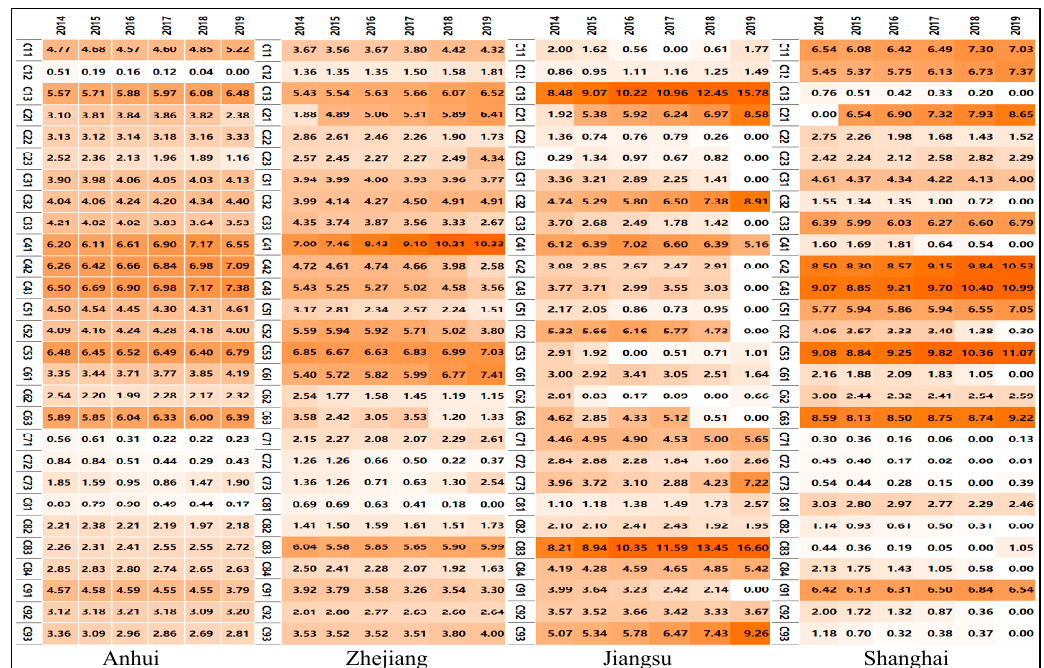
Figure 8. Obstacle scores of the secondary indices in the YRD region.